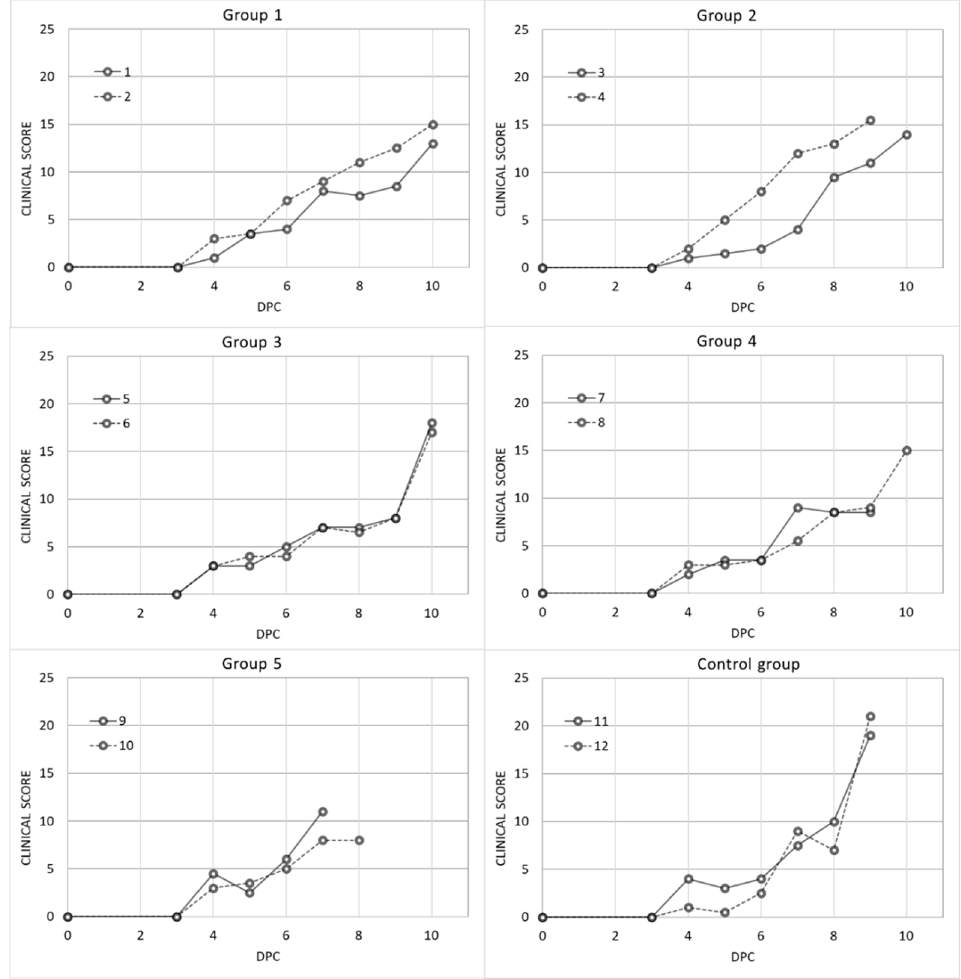
Figure 1. Individual post-challenge clinical scores of domestic pigs from the different vaccinated groups: Group 1 (Pol16-inactivated, MF59), Group 2 (Pol16-inactivated, Silica oil), Group 3 (Pol16-inactivated, mGNE), Group 4 (Pol16-inactivated, Montanide ISA201), group 5 (Pol16-inactivated), and the control group.